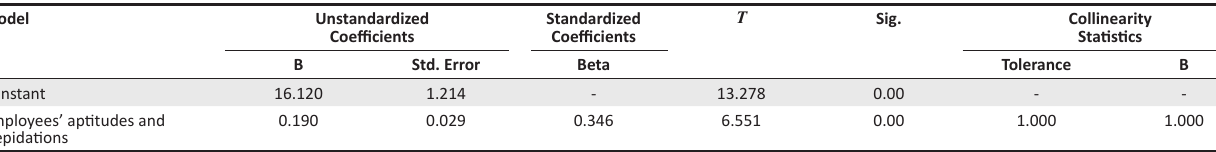
TABLE 4: Analysis of variance a . TABLE 5: Pearson coefficients.